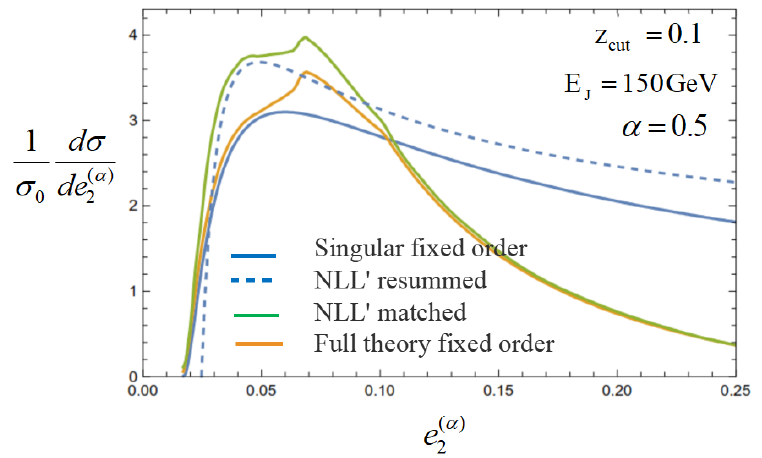
Figure 12 . Comparison of resummed and (cid:12)xed-order cross sections for massive quark